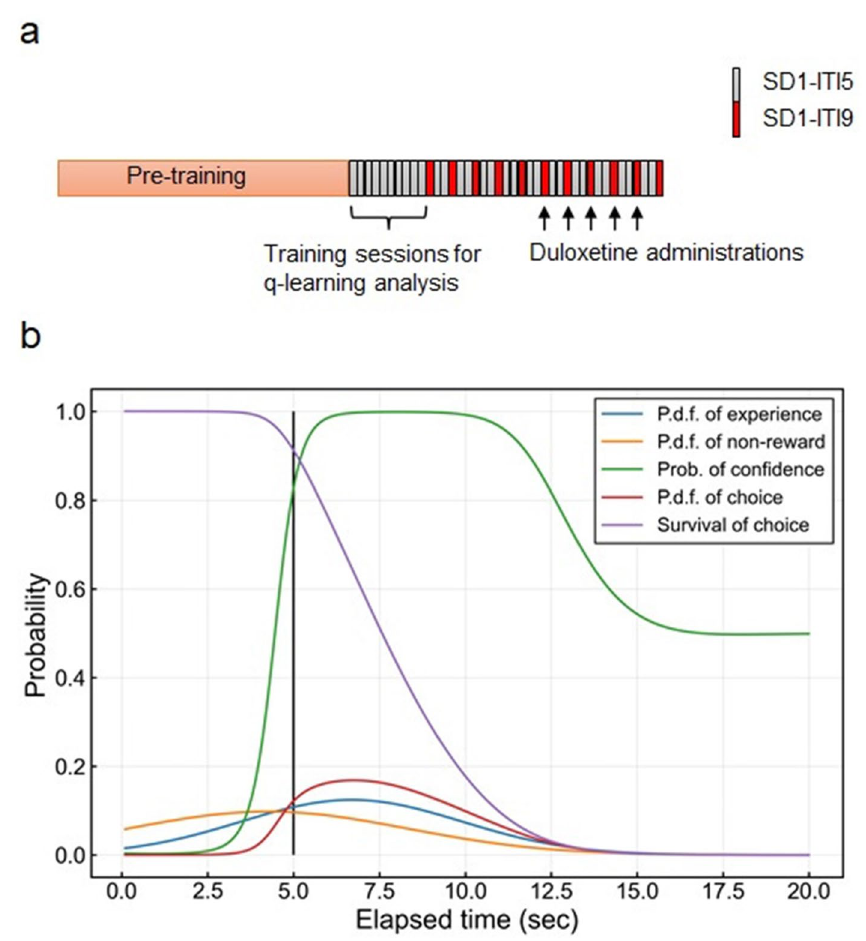
Figure 6. Sessions used for q-learning analysis and duloxetine administrations and illustration of the functions used in the q-learning model in the 3-choice serial reaction time task. ( a ) Training sessions after a pre-training period were used for q-learning analysis to assess the learning process. A gray or red box indicates one session. Duloxetine was administered after five SD1-ITI9 were completed. SD1-ITI5 stands for stimulus duration of one second and inter trial interval (ITI) of 5 s. SD1-ITI9 stands for stimulus duration of one second and inter trial interval (ITI) of 9 s. ( b ) X-axis represents elapsed time (sec) from the starting time of trials. The vertical black line at 5 s indicates the timing of the light stimulus. Each line represents the following: Probability density function (p.d.f.) of experience (blue); the p.d.f. of experience distribution. P.d.f. of non-reward (orange); the p.d.f. of non-reward distribution. Prob. of confidence (green); the probability of confidence at each elapsed time. P.d.f. of choice (red); the p.d.f. of choice distribution. Survival of choice (purple): the survival function of the choice